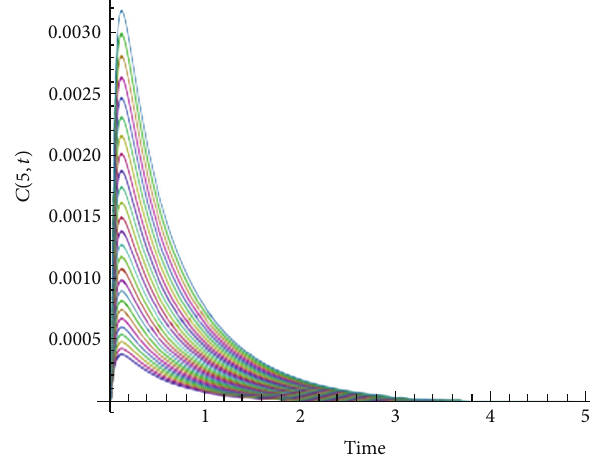
Figure 17: Influence of the aperture size on the value of the concentration for a fixed distance. Time in